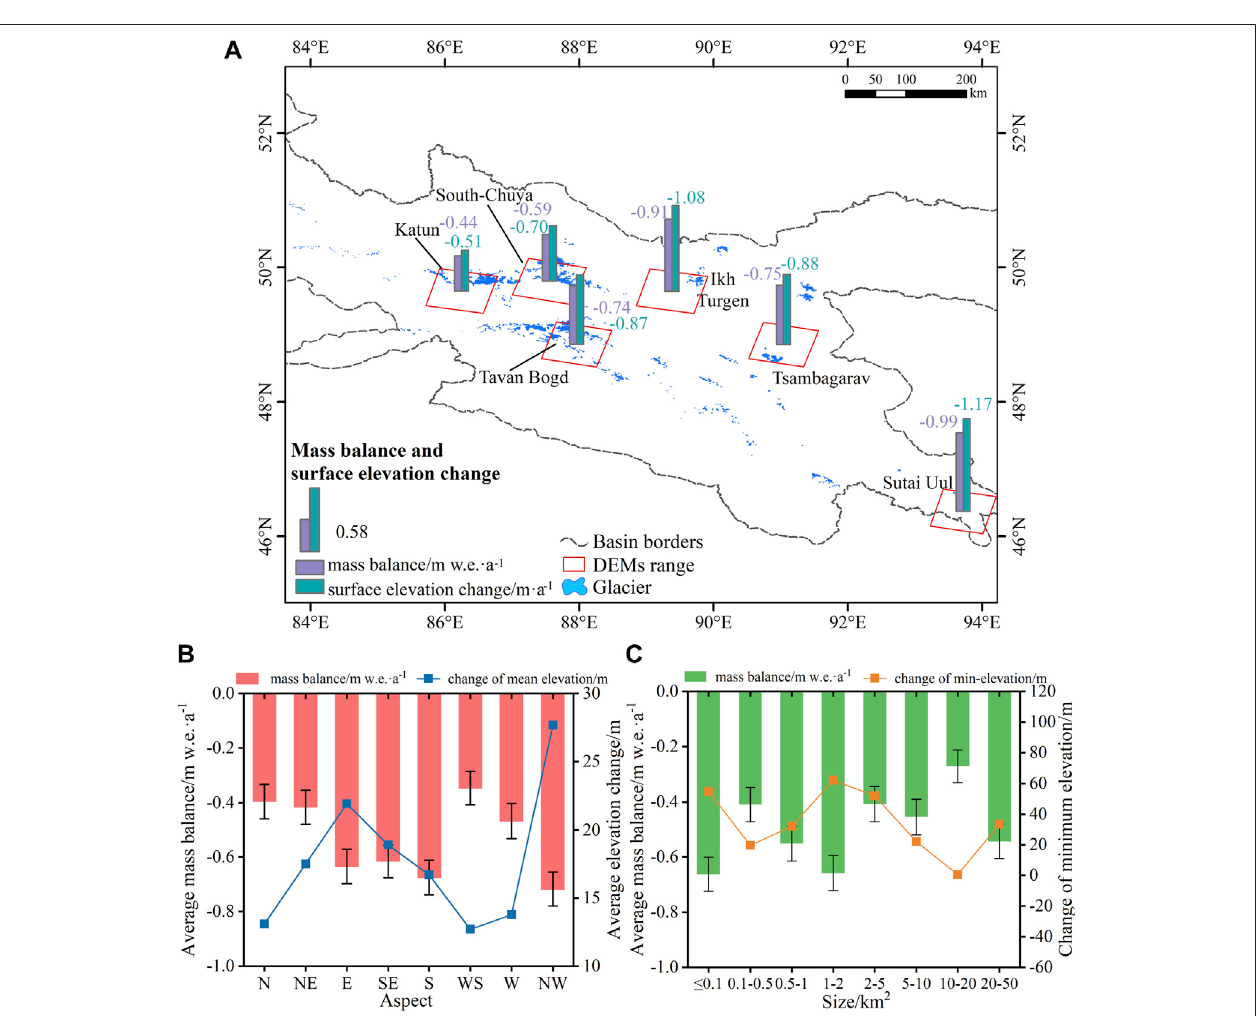
FIGURE 7 | Mass balance from 2000 to 2020 in the Altai Mountains. (A) Spatial distribution of mass balances and surface elevation changes for DEMs-covered glaciers. (B) Glaciermassbalancesandmeanelevationchangesofdifferentaspects. (C) Glaciermassbalancesandminimumelevationchangesofdifferentsizeclasses.